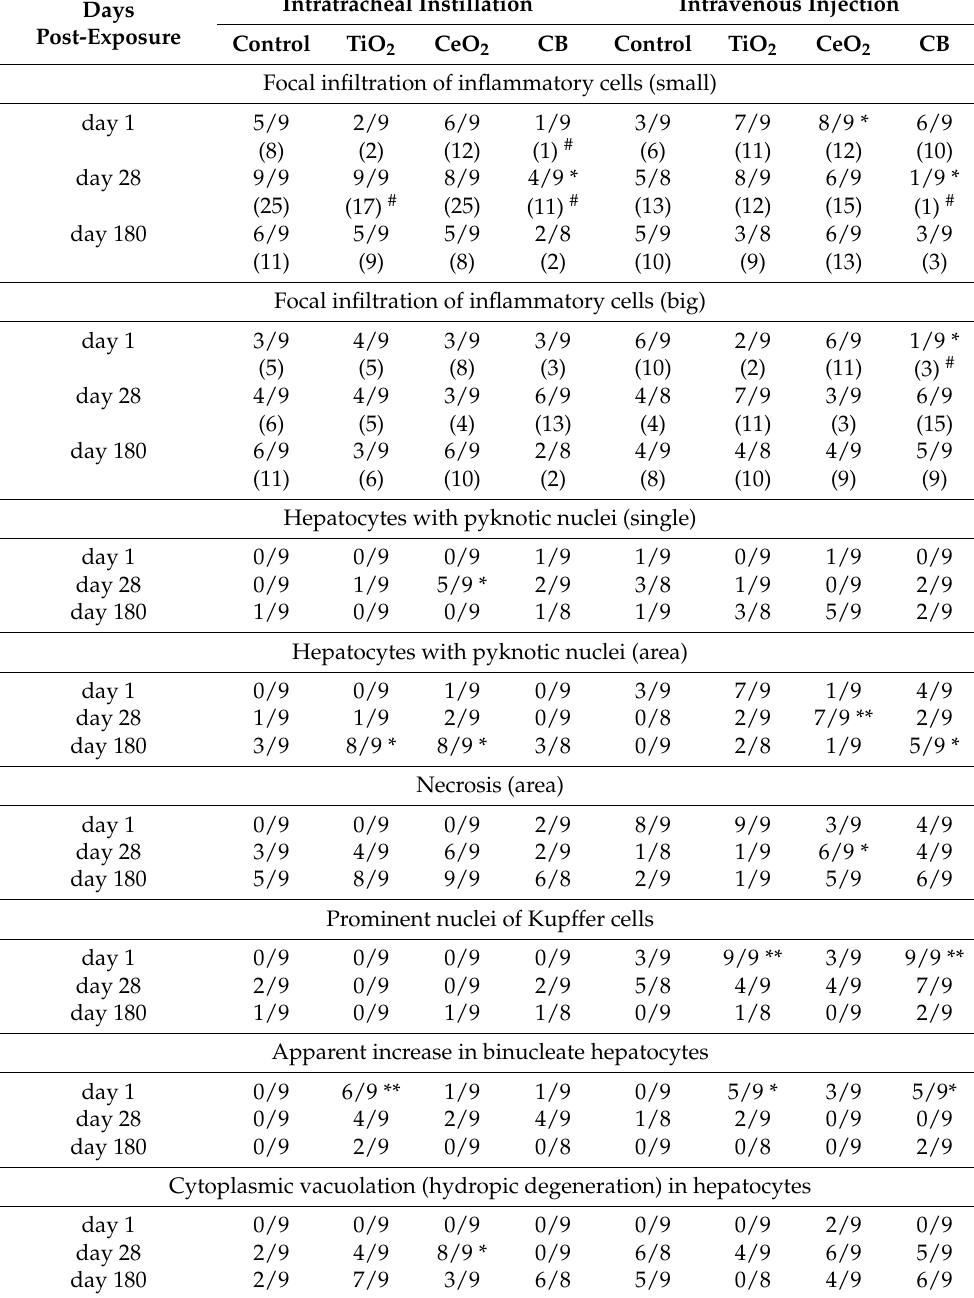
Table 4. Microscopic liver changes—statistically significantly different from control groups—1, 28 or 180 days after a single exposure of mice to 162 µ g of TiO 2 , CeO 2 and carbon black (CB) nanoparticles administered by intratracheal instillation or intravenous